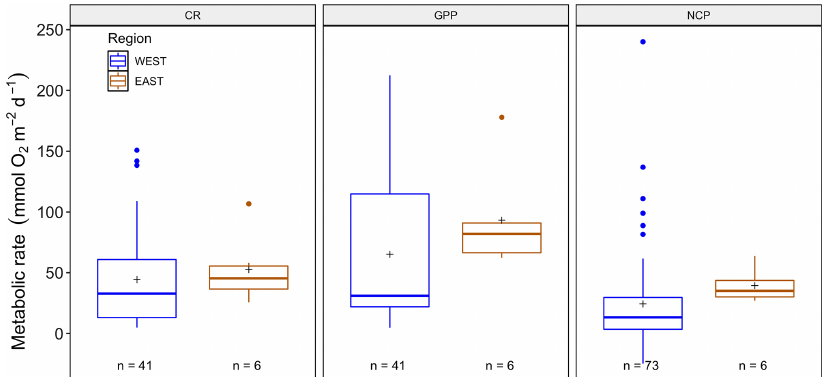
Figure 5. Metabolic rates for GPP, NCP and CR (mmolO 2 m − 2 d − 1 ) for the eastern (blue) and western (orange) Mediterranean as obtained from the benthic-chamber dataset for Posidonia oceanica . Upper and lower hinges correspond to the upper and lower quartiles. The line inside the boxes corresponds to the median; the mean is marked by a crosshair; and the error bars are based on minimum and maximum standard deviation for each parameter. No differences were found for metabolic rates between